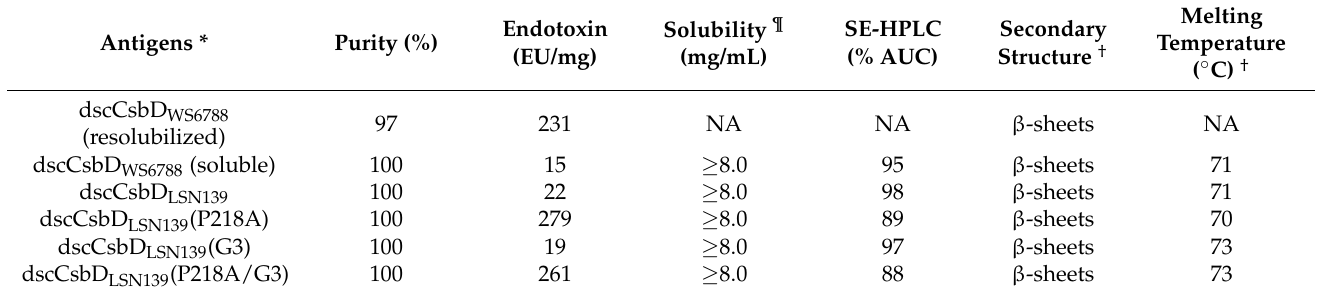
Table 1. Physicochemical characterization of CsbD-based vaccine